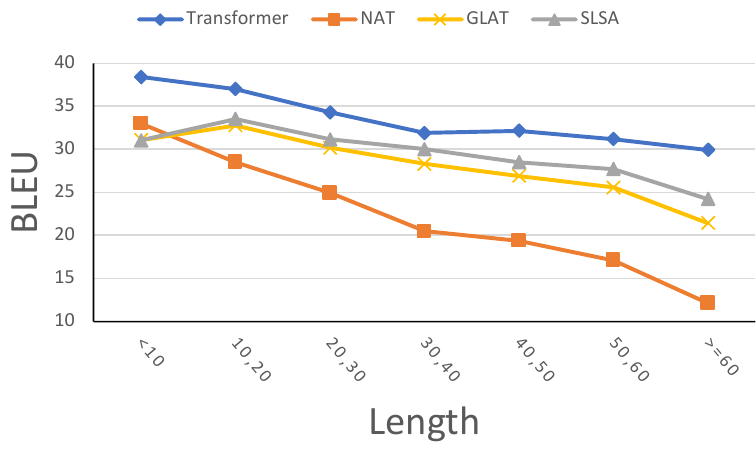
Figure 3. The results from different lengths on the IWSLT14 DE → EN.